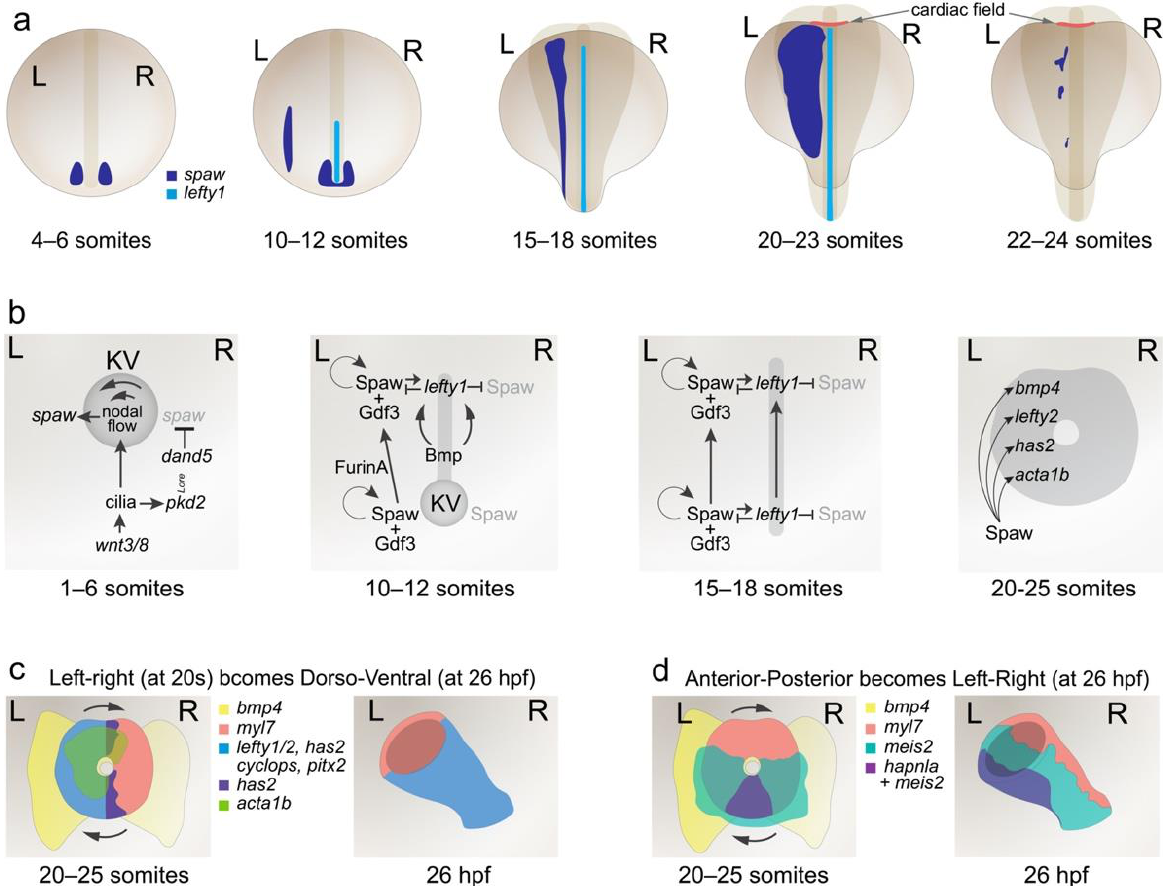
Figure 1. Left–right patterning in the zebrafish axis and cardiac disc. ( a ) Time-course of spaw and lefty1 expression during establishment and propagation of lateral spaw expression. spaw is initiated peri-KV at 4–6 somites (4–6 s) and becomes enriched on the left side of the node, and expression is induced in the PLPM by 10–12 s. lefty1 is induced by spaw in the midline and expression propagates up the embryo rostrally from 12 to 18 s. At 20–23 s, spaw expression is broad and by 24 s, expression is almost extinguished. ( b ) Models of the genetic pathways involved in left–right axis patterning at different stages of zebrafish development. ( c ) At the cardiac disc stage (20–25 s), there is significant left–right patterning within and around the cardiac disc. Upon tube formation, this left–right organisation is repositioned to become dorso–ventral within the tube by 26 h post fertilization (hpf). ( d ) Anterior–posterior markers within the cardiac disc at 20–25 s become repositioned in the cardiac tube to take on left–right asymmetry in the heart tube at 26 hpf. A more detailed representation of cardiac morphogenesis is depicted in Figure 2.